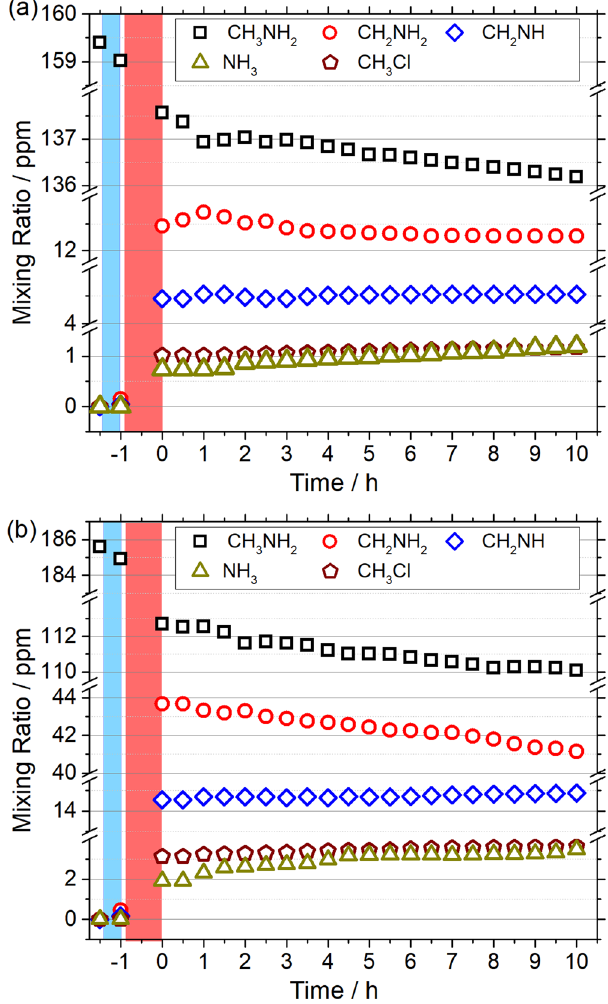
Fig. 3 Temporal evolution of mixing ratios of CH 3 NH 2 , • CH 2 NH 2 , CH 2 NH, NH 3 , and CH 3 Cl upon UV and IR irradiation of CH 3 NH 2 /Cl 2 / p -H 2 matrices, followed by maintenance in darkness. a [H] 0 /[CH 3 NH 2 ] 0 ≈ 2.1 and [CH 3 NH 2 ] 0 = 159 ppm, b [H] 0 /[CH 3 NH 2 ] 0 ≈ 7.2 and [CH 3 NH 2 ] 0 = 186 ppm. The regions shaded with blue and red correspond to periods of UV and IR irradiation,